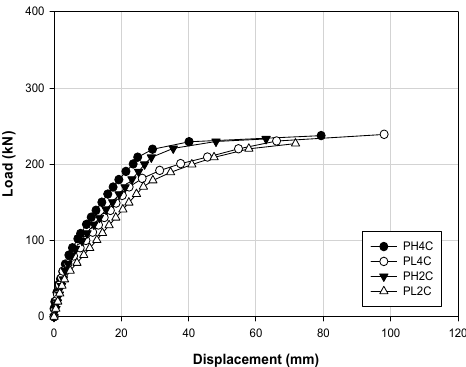
Figure 5. Load–displacement responses upon prestressing of PSC specimens.